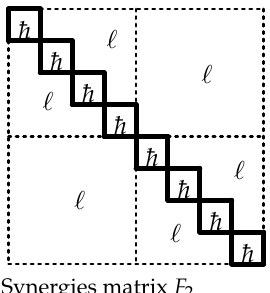
Figure 9. Benchmark graph. Model 2.